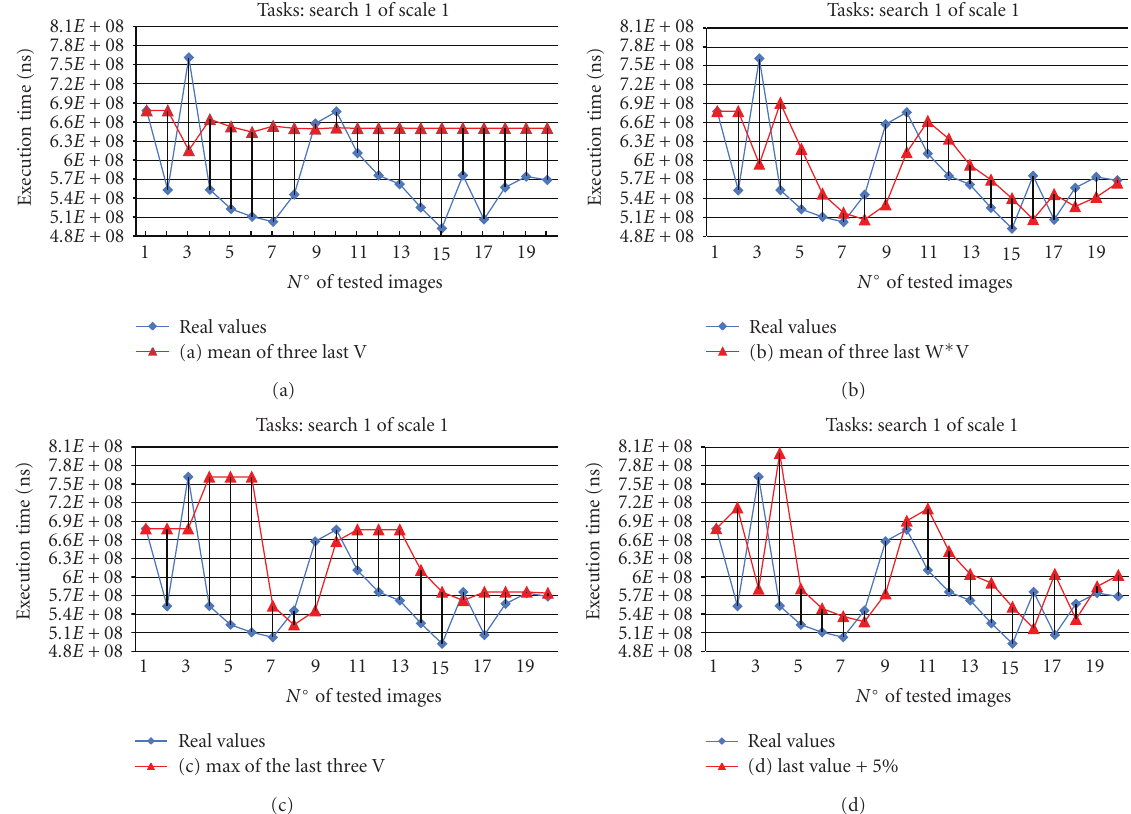
Figure 13: (a) Comparison between real measured values of the execution time of task search 1 of scale 1 and predicted values using method (a). (b) Comparison between real measured values of the execution time of task search 1 of scale 1 and predicted values using method (b). (c) Comparison between real measured values of the execution time of task search 1 of scale 1 and predicted values using method (c). (d) Comparison between real measured values of the execution time of task search 1 of scale 1 and predicted values using method (d).